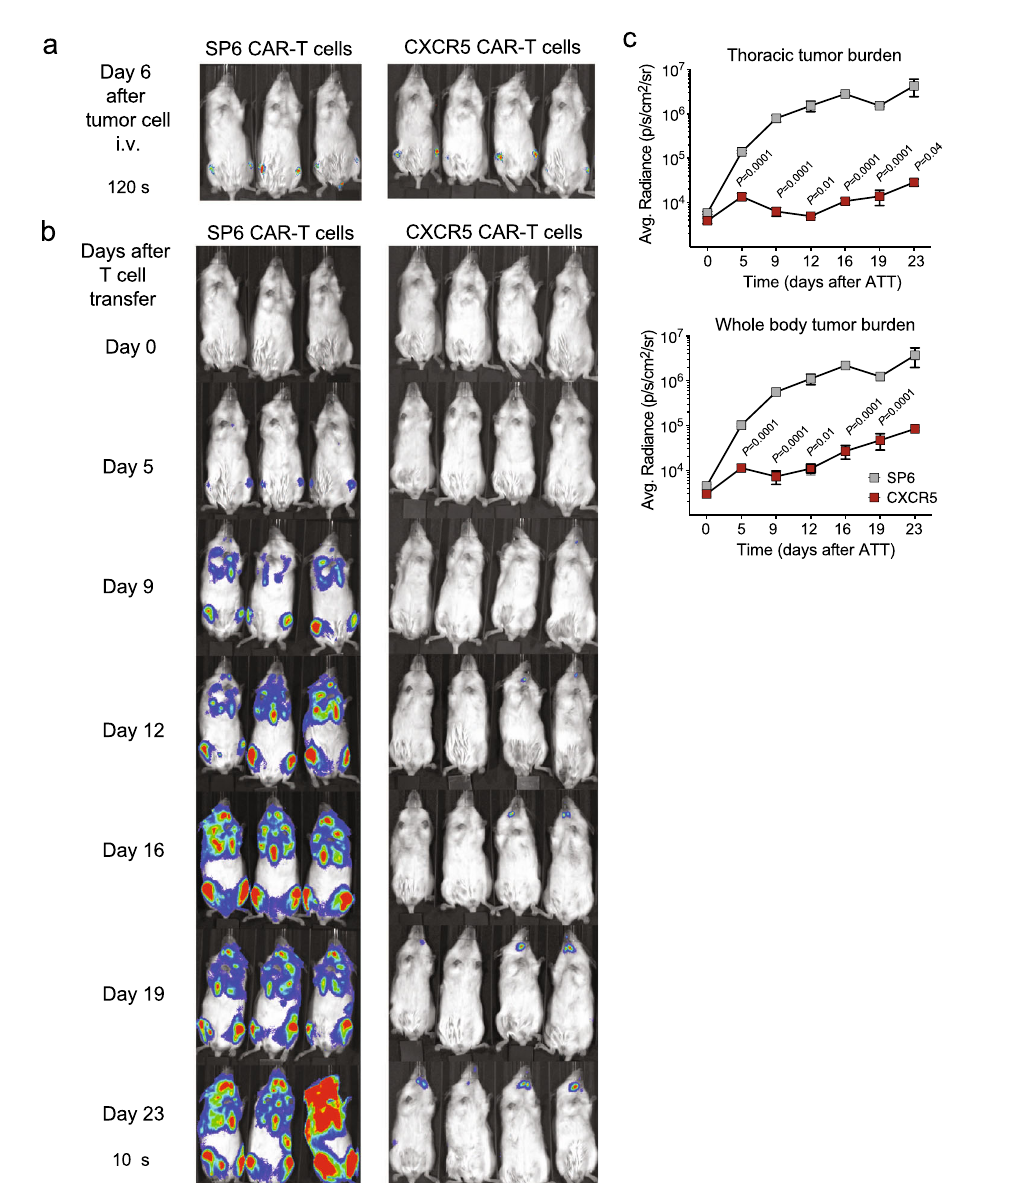
Fig. 4 Primary human non-lymphoid cells derived from healthy tissues and cancer cell lines do not activate anti-CXCR5 CAR-T cells. CXCR5 surface expression on ( a ) primary human cells (HUVEC, human umbilical vein endothelial cells; HUAEC, human umbilical artery endothelial cells; HPNC, human perineurial cells; HA, human astrocytes; HCoEpiC, human colonic epithelial cells; HCerEpic, human cervical epithelium cells; HUC, human urothelial cells; HN, human neurons) and on ( b ) cancer cell lines (HepG2, hepatocellular carcinoma; SW620, colon carcinoma; HEK293, embryonic kidney epithelial cells). Selected primary cells were stimulated for 24 h with ( + ) or without ( − ) IFN γ (25 ng/ml). CXCR5-transduced HEK293 cells served as a positive control. c , d UT, SP6, or CXCR5 CAR-transduced T cells were cocultured for 22 h with human primary cells and cell lines pretreated with or without IFN γ (25 ng/ml). The JeKo-1 cell line served as a positive control. IFN γ release was quanti fi ed in supernatants by ELISA. Max, CAR-T cells and PMA/Ionomycin; Min, CAR-T cells only. a , b Representative data of n = 2 independent experiments. c , d n = 2 independent experiments with n = 7 ( c ) or n = 6 ( d ) individual donors, except for SW620, HEK293, and HEK CXCR5 + in ( c ), which show n = 3 individual donors. Bars represent mean ± SEM; P values are calculated for